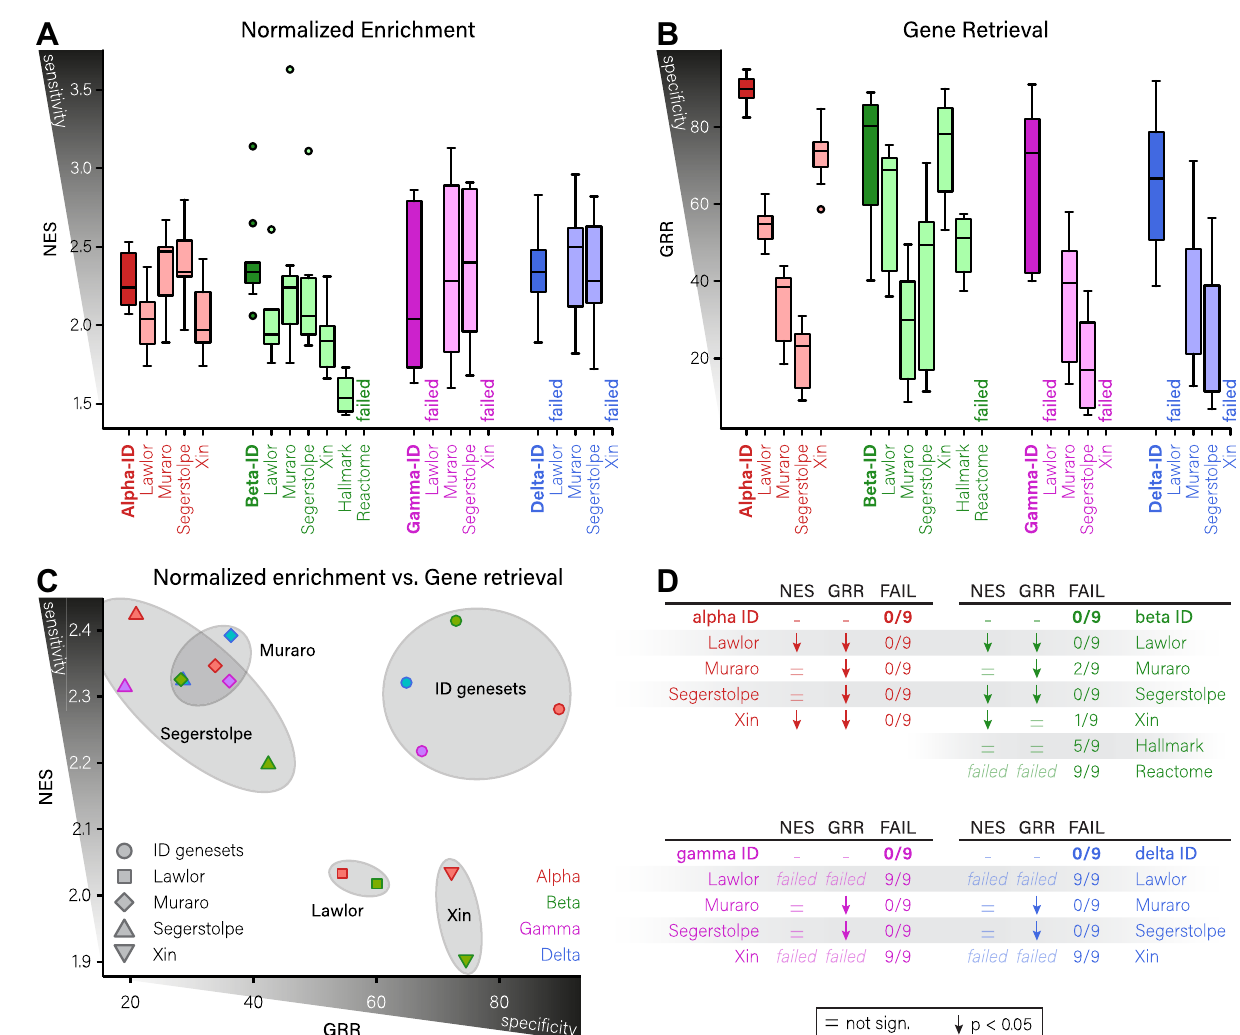
Fig. 4 Evaluation of identity genesets reveals superior on- and off-target scoring compared to previously published ID lists. A , B Box plots of normalized enrichment (sensitivity; A ) and Gene Retrieval Rate (speci fi city; B ) for our islet cell type-speci fi c ID genesets compared to previously published ID lists, using three independent datasets for evaluation ( n = 9 per condition). Box plots are colour-coded per cell type ( α -, β -, γ - and δ -cells in red, green, magenta and blue, respectively), and distribution follows standard boxplot formatting as min-Q1-median-Q3-max, with individual dots marking outliers. Darker colours indicate our ID genesets. C Scatterplot indicating the relation between NES/sensitivity and GRR/speci fi city for the different ID genesets. Larger genesets from the Muraro and Segerstolpe datasets score well on sensitivity at the expense of GRR/speci fi city. The smaller genesets from the Lawlor and Xin datasets are more speci fi c, at the expense of sensitivity. In our ID genesets, we have managed to optimize the trade-off between sensitivity and speci fi city. Dots are colour coded per cell type ( α -cells in red, β -cells in green, γ -cells in magenta, δ -cells in blue) and shaped per dataset. D statistics for on-target, off-target and evaluation metric scoring. Comparisons were made using Wilcoxon signed-rank test; = indicates no signi fi cant difference compared to our ID genesets, ↓ indicates a signi fi cantly lower score compared to our ID genesets, ‘ failed ’ indicates all analyses for this geneset failed. NES normalized enrichment score, GRR gene retrieval rate, FAIL number of geneset analyses that did not produce output. Source data are provided as a source data fi